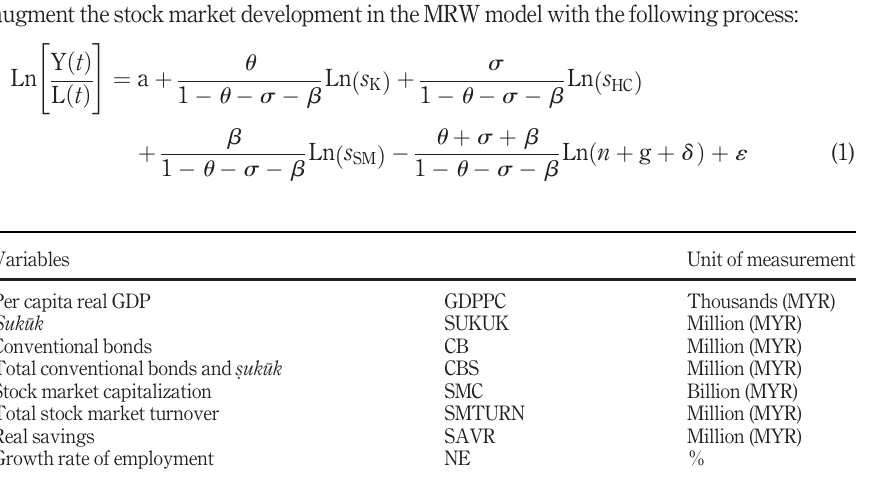
Table 1. Variables